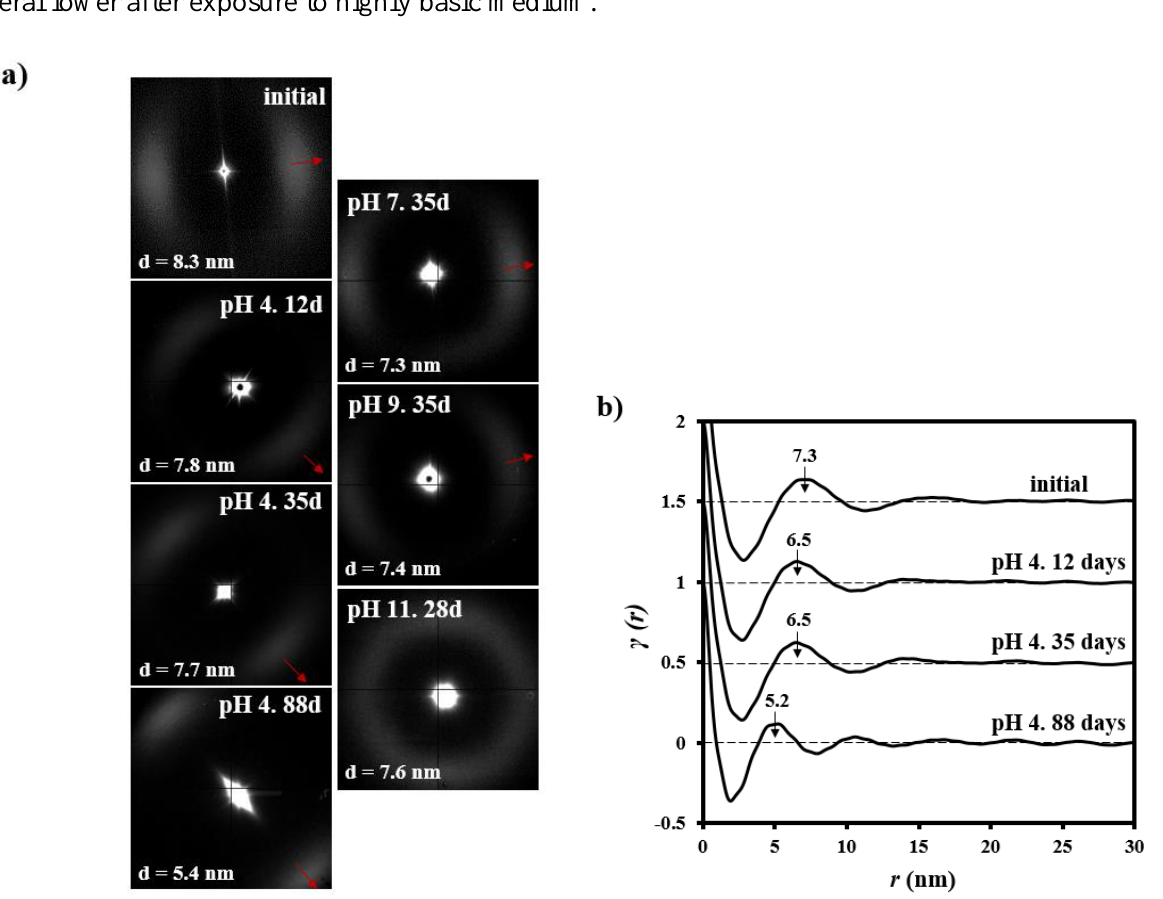
Figure 13. ( a ) SAXS patterns of the initial γ irradiated GL- b -[GL- co -TMC- co -CL]- b -GL sample and after exposure to pH 4 for 12, 35 and 88 days, pH 7 for 35 days, pH 9 for 35 days and pH 11 for 28 days. Red arrows indicate the meridional fiber direction; ( b ) Comparison between correlation functions of γ irradiated GL- b -[GL- co -TMC- co -CL]- b -GL sample for: initial sample, after exposure to pH 4 for 12, 35, and 88